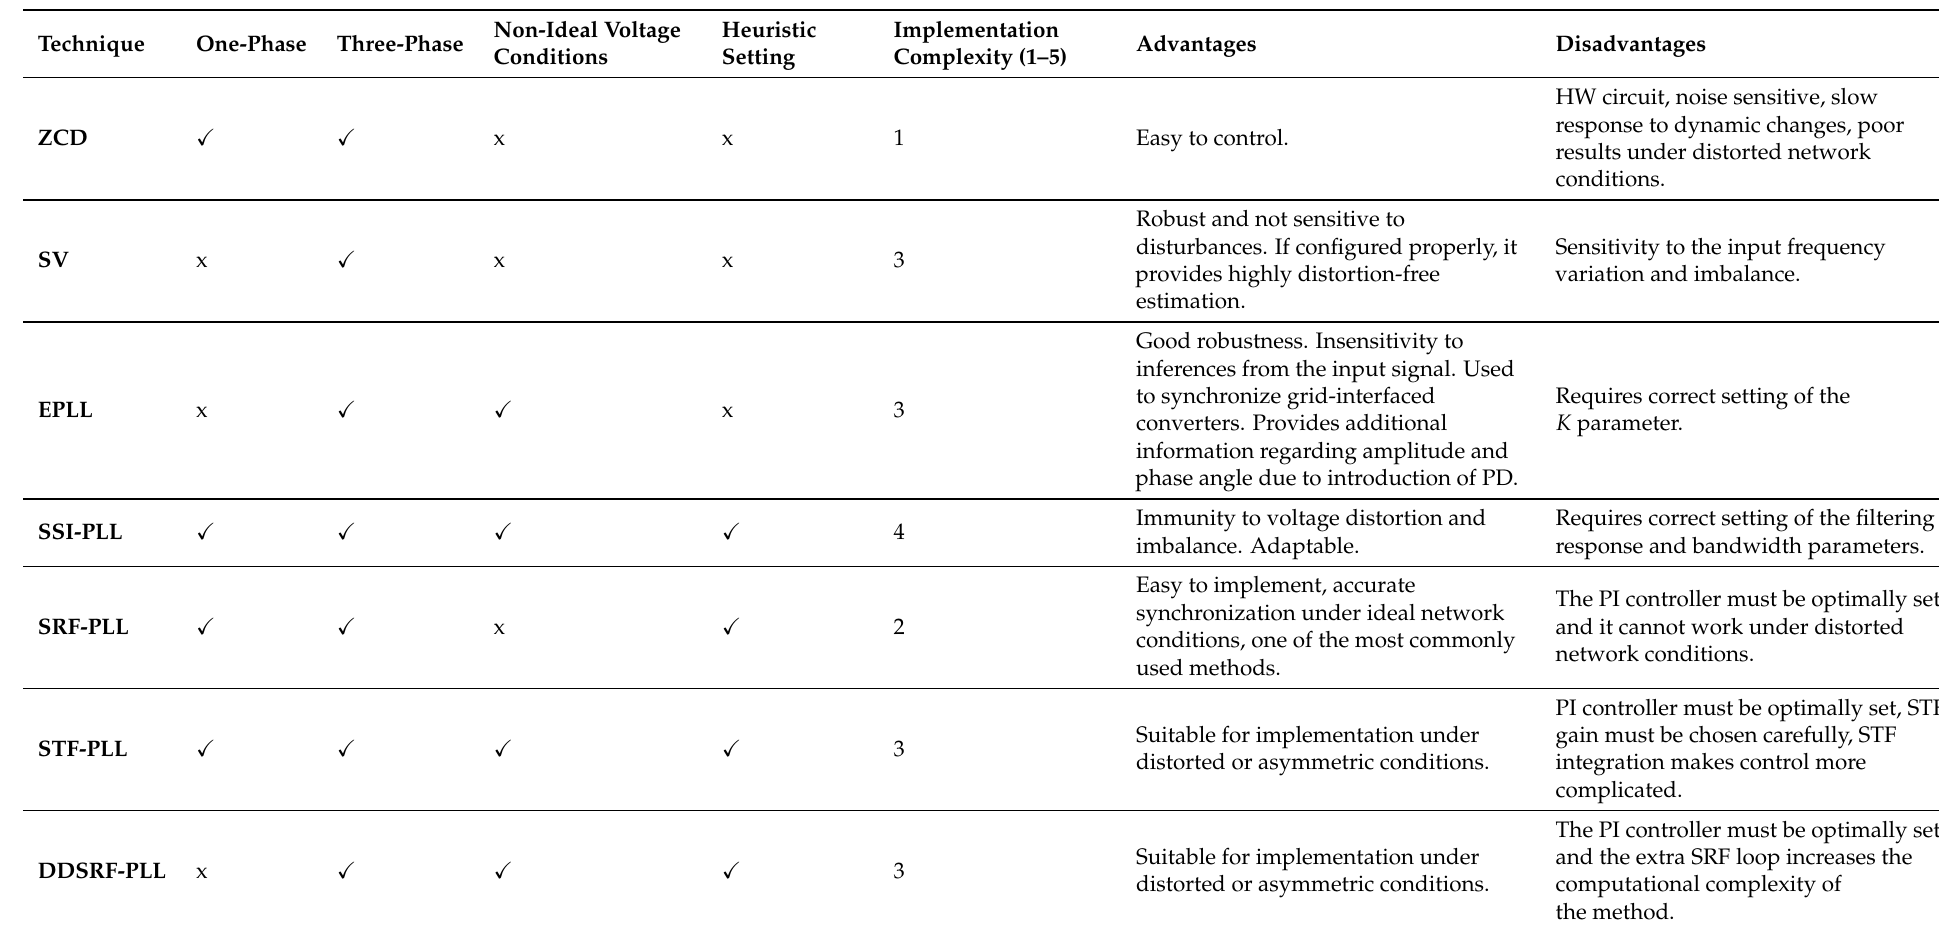
Table 2. Summary of mentioned synchronisation